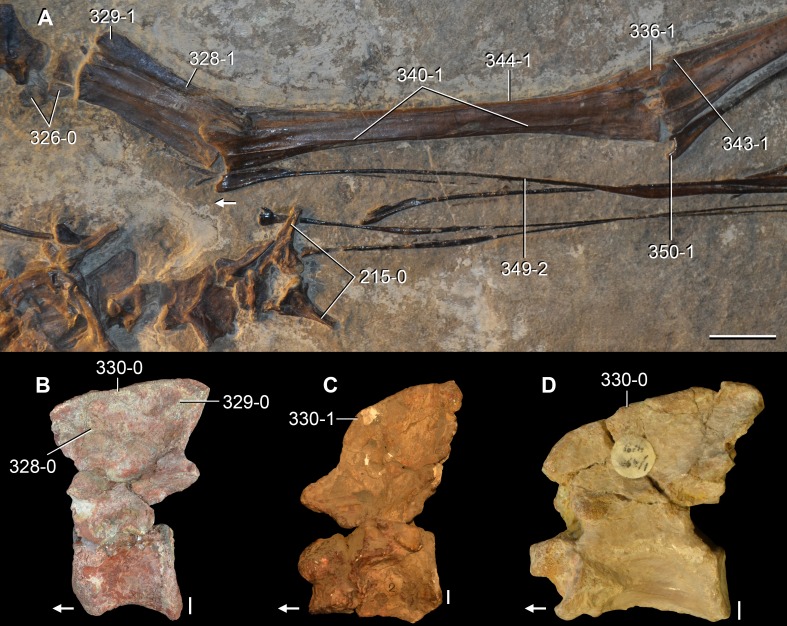
Anterior cervical vertebrae of Triassic archosauromorphs in left lateral view.(A) Tanystropheus longobardicus (PIMUZ T2189); (B) Sarmatosuchus otschevi (PIN 2865/68-22); (C) Parasuchus hislopi (ISI R42); and (D) Silesaurus opolensis (ZPAL AbIII unknown number). Numbers indicate character-states scored in the data matrix and the arrows indicate anterior direction. Scale bars equal 2 cm in (A), 5 mm in (B, C), and 2 mm in (D).